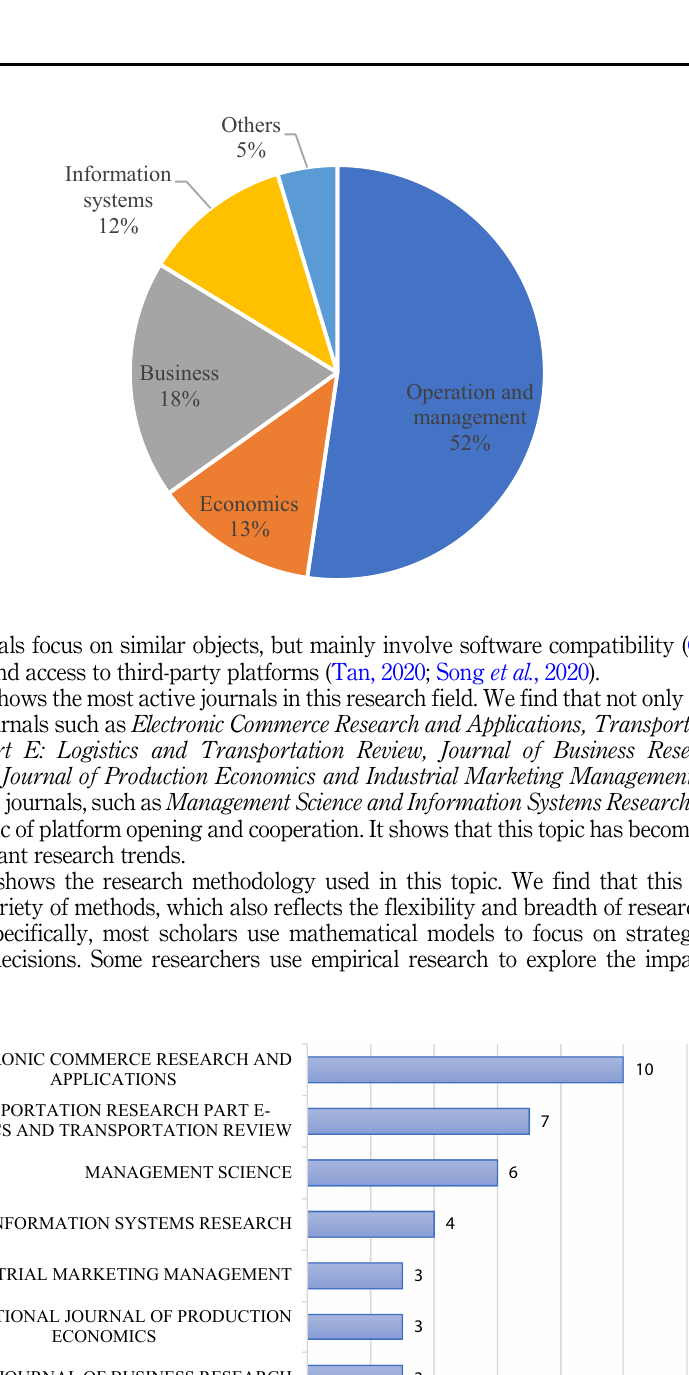
Figure 5. Journals active in this